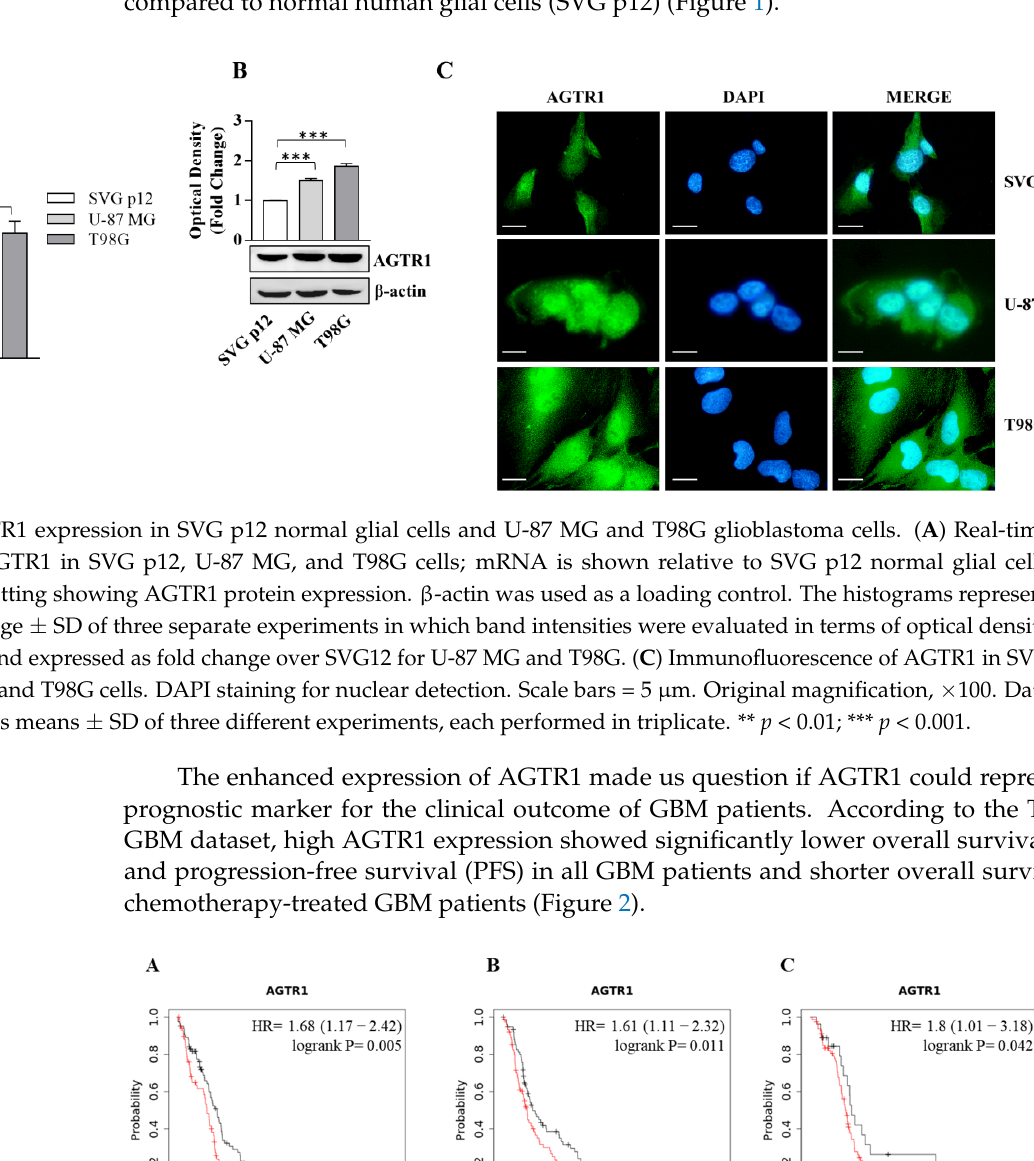
Figure 3. Effects of Ang II receptor antagonist Losartan on Ang II-induced AGTR1 expression in U-87 MG and T98G glioblastoma cells. ( A , B ) Real-time RT-PCR and immunoblotting assay for AGTR1 mRNA and protein expression in U-87 MG and T98G cells treated with vehicle (−) or the Ang II 0.1, 5, and 10 µM for 24 h. β-actin was used as a loading control. The histograms represent the mean average ± SD of three separate experiments in which band intensities were evaluated in terms of optical density arbitrary unit and expressed as fold change over vehicle (−) for Ang II treatment. ( C , D ) AGTR1 mRNA and protein expression in U-87 MG and T98G cells treated with vehicle (−) and Ang II 5 µM alone or in combination with LOS 5 µM for 24 h. The histograms represent the mean average ± SD of three separate experiments in which band intensities were evaluated in terms of optical density arbitrary unit and expressed as fold change over vehicle (−) for Ang II treatment or fold over Ang II for Ang II in combination with LOS. β-actin was used as a loading control. Data represent the mean ± SD of three different experiments, each performed in triplicate. ** p < 0.01; *** p < 0.001. Ang II/AGTR1 signaling pathway appeared more active in both glioblastoma cell lines displaying an enhanced phosphorylated status of STAT3 and MAPK in basal condi- tion, which was further increased after Ang II short exposure (Figure S1).